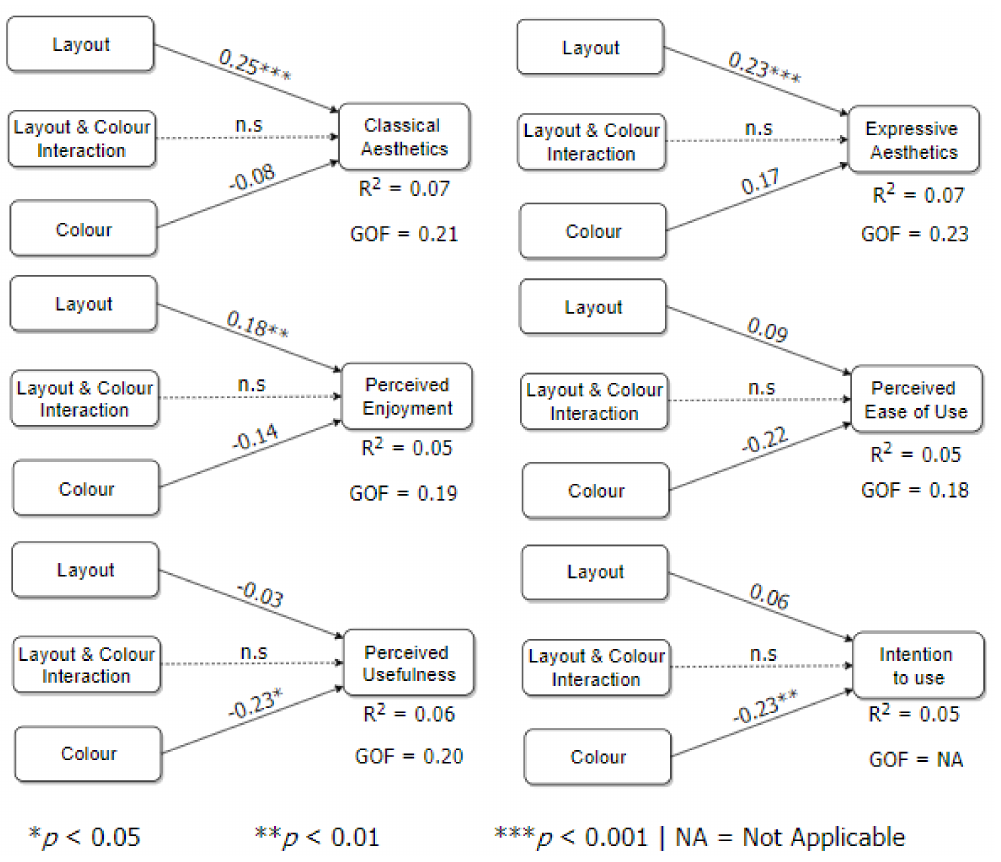
Figure 3. Relationship between web design elements and TAM constructs. The list layout is coded as 0 and the grid layout as 1. Colour represents colour temperature ranging from blue (coolest) to red